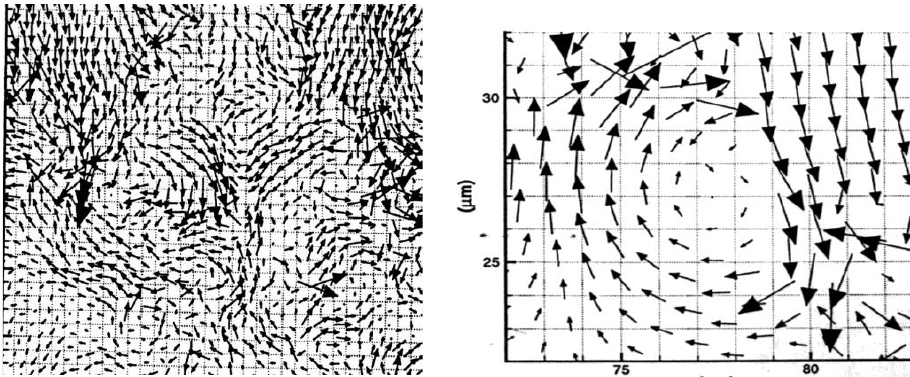
8 Figure 5. The rotational cells in shock-deformed VT14 titanium alloy targets.